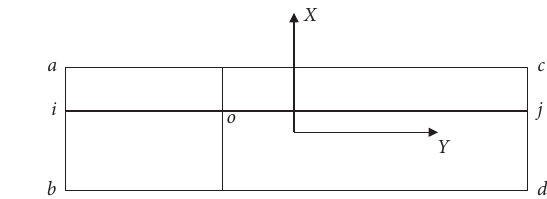
Figure 2: Top view of the